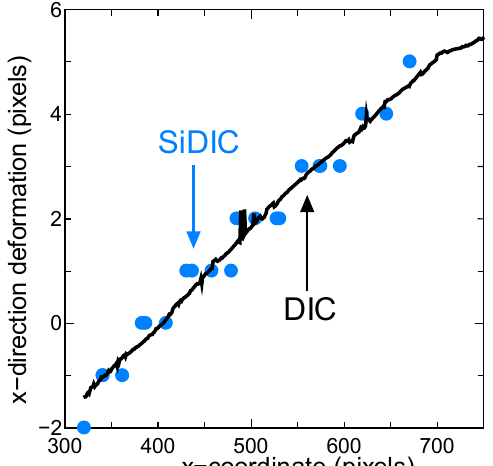
Figure 6. Horizontal displacement determined by DIC superimposed onto the photograph of the balloon.